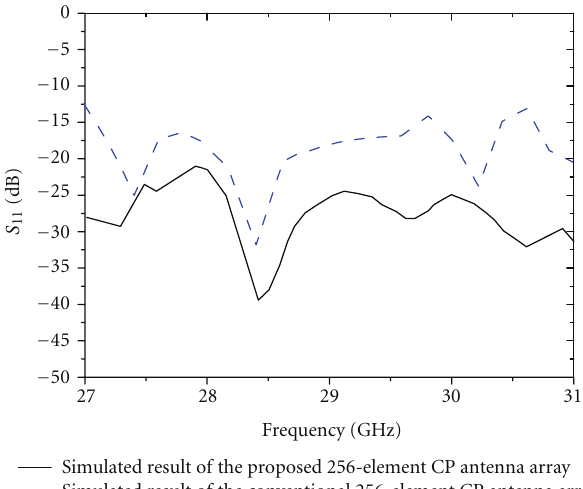
Simulated result of the proposed 64-element CP antenna array Measured result of the proposed 64-element CP antenna array Simulated result of the conventional 64-element CP antenna